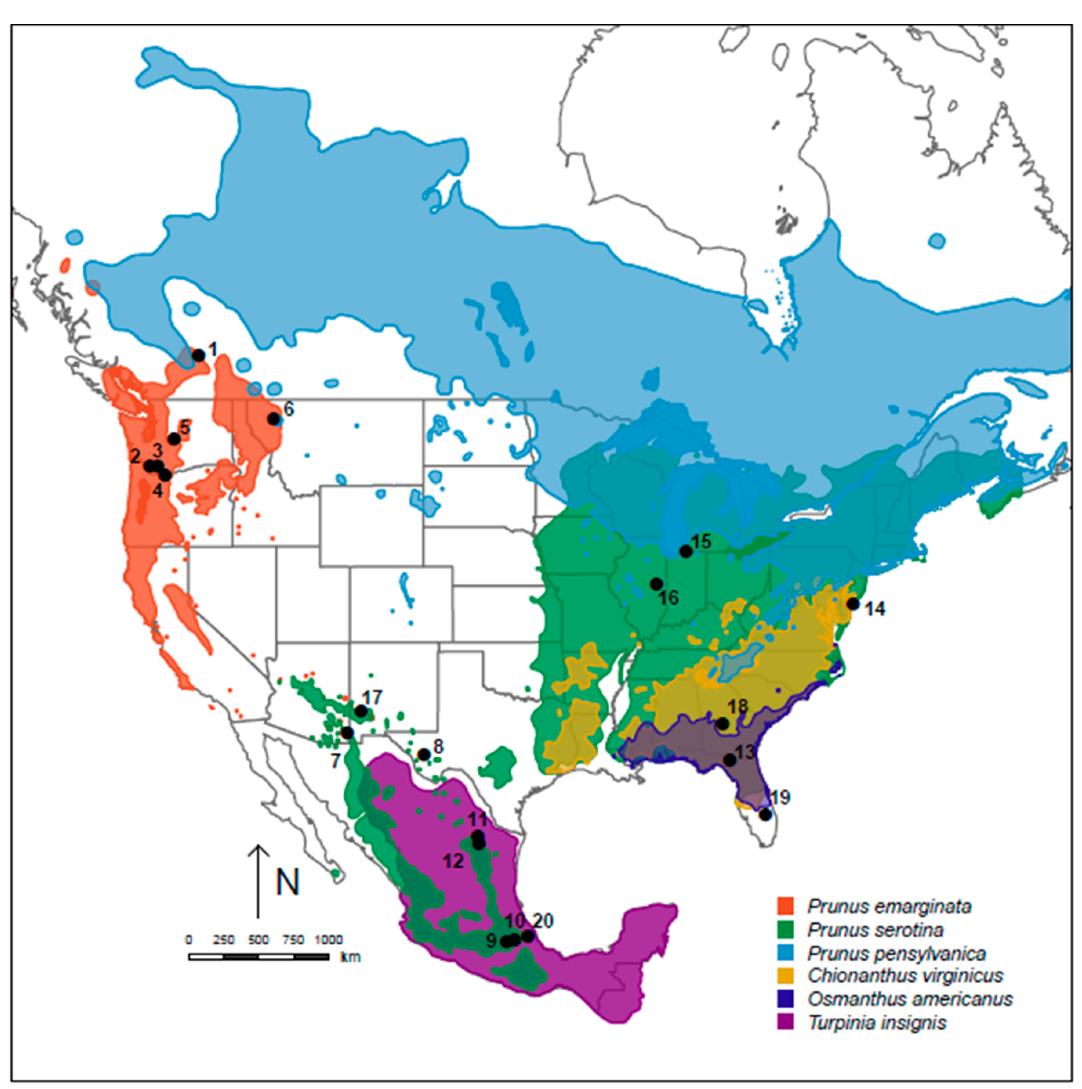
degree to which they have evolved intrinsic postzygotic isolation.